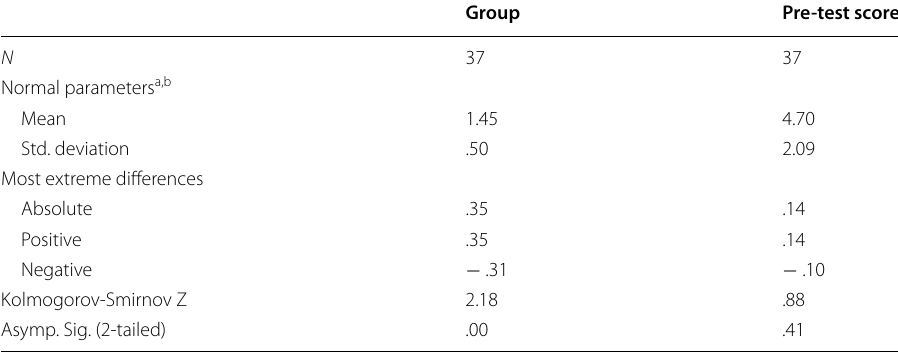
a Test distribution is normal b Calculated from data